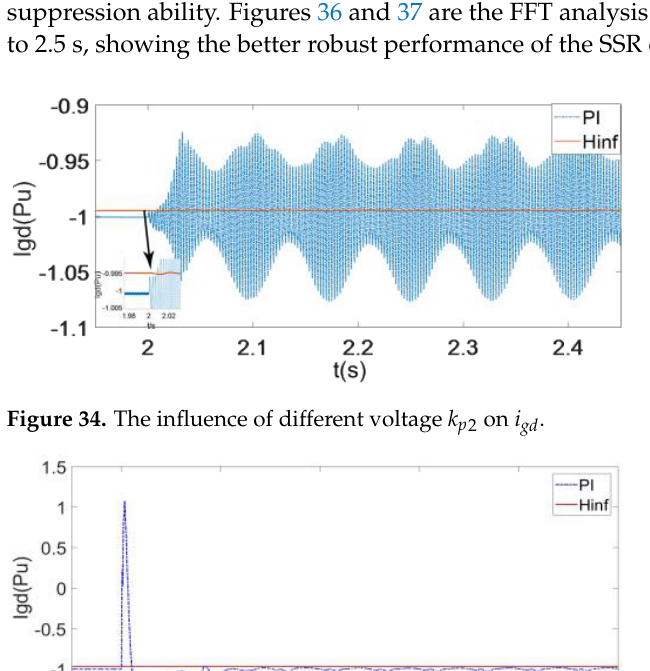
Figure 35. The influence of k i2 on i gd.